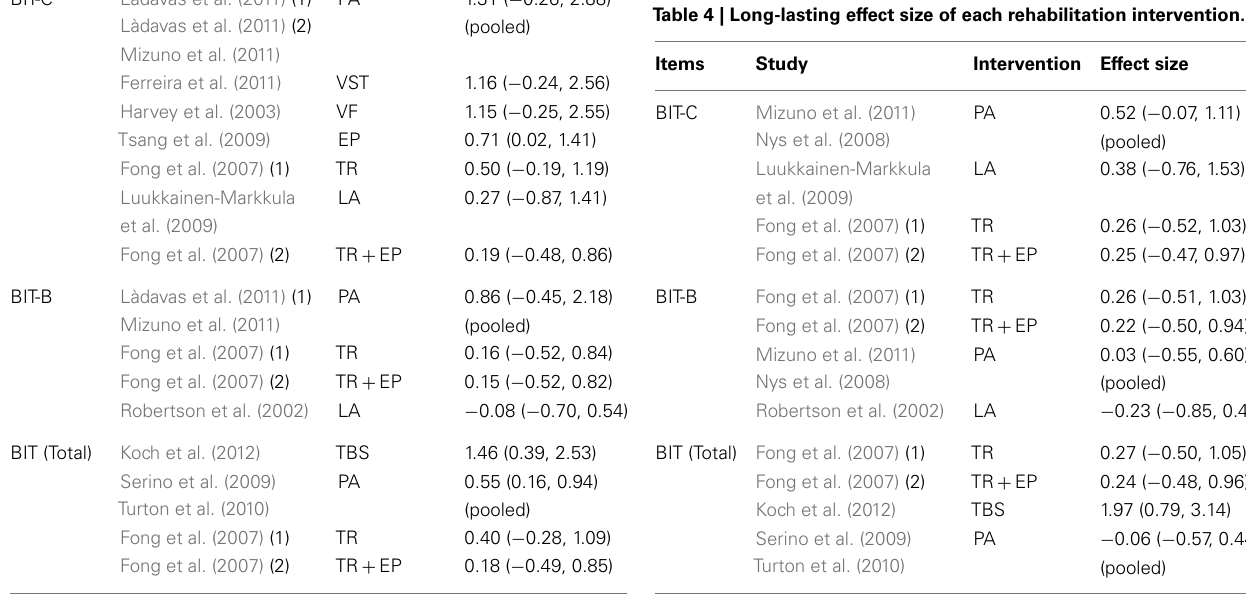
Table 5 | PA intervention on